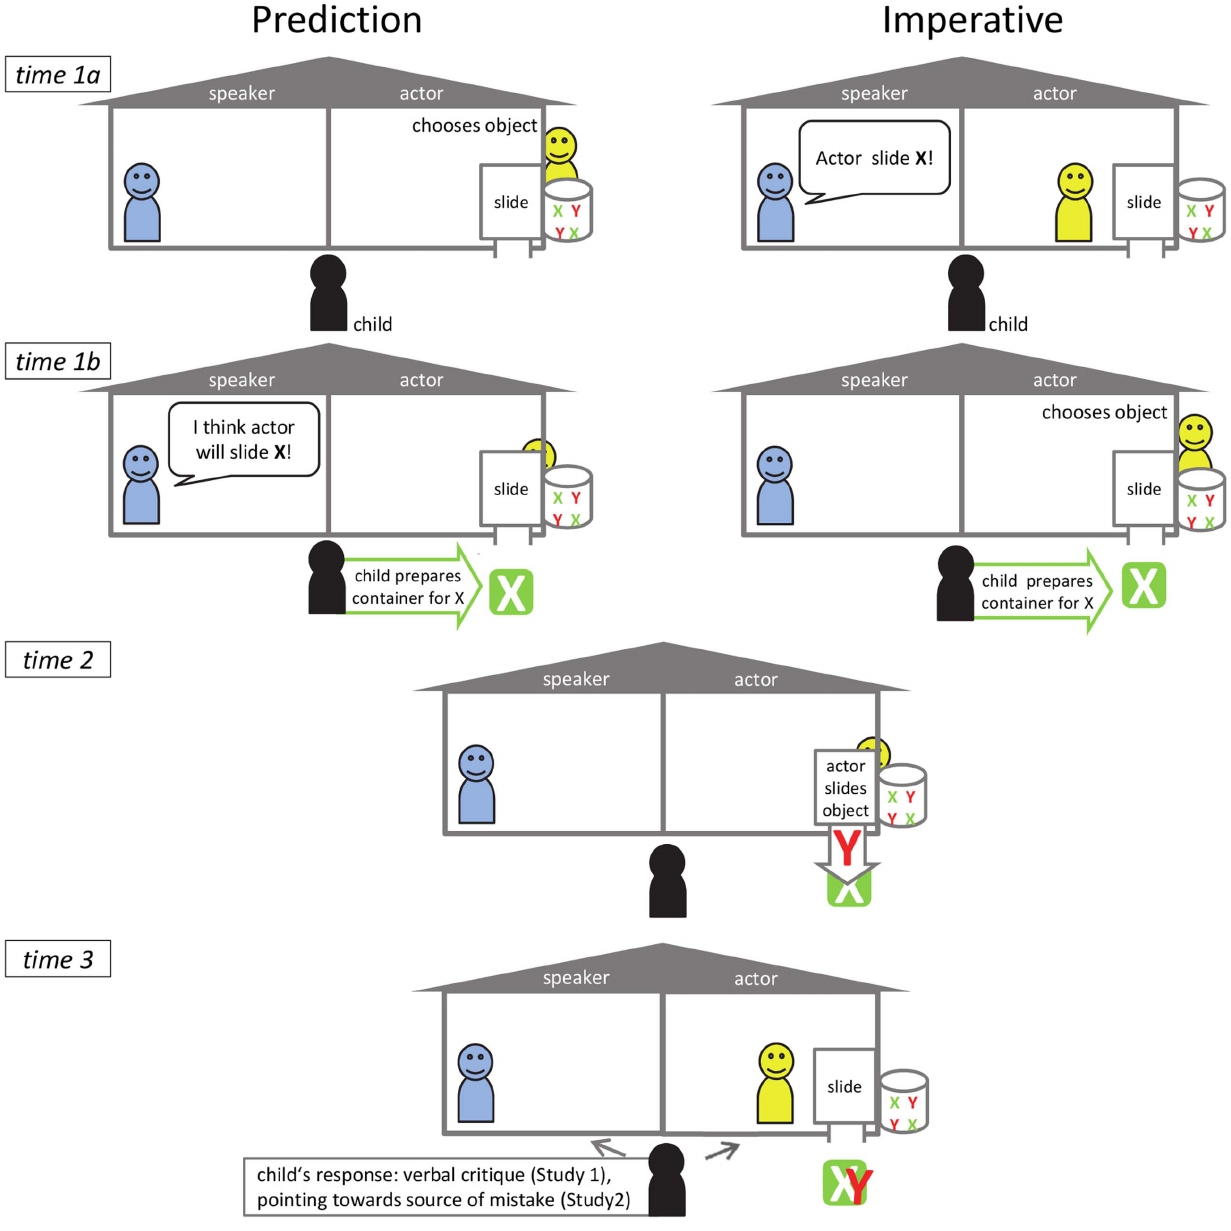
Figure 1. Schematic overview of the procedure. chematic overview of the procedure in imperative and the prediction conditions (Study 1 and Study 2).